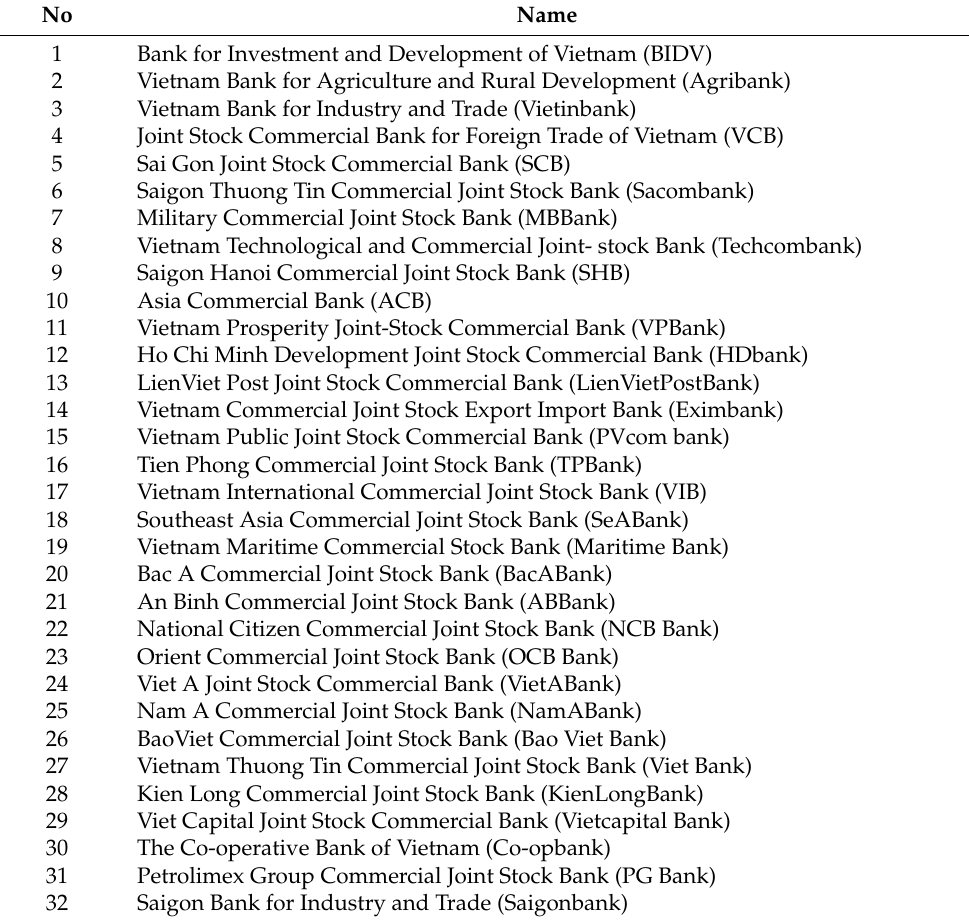
Table A1. List of domestic Vietnam banks for the period 2008 to 2017.